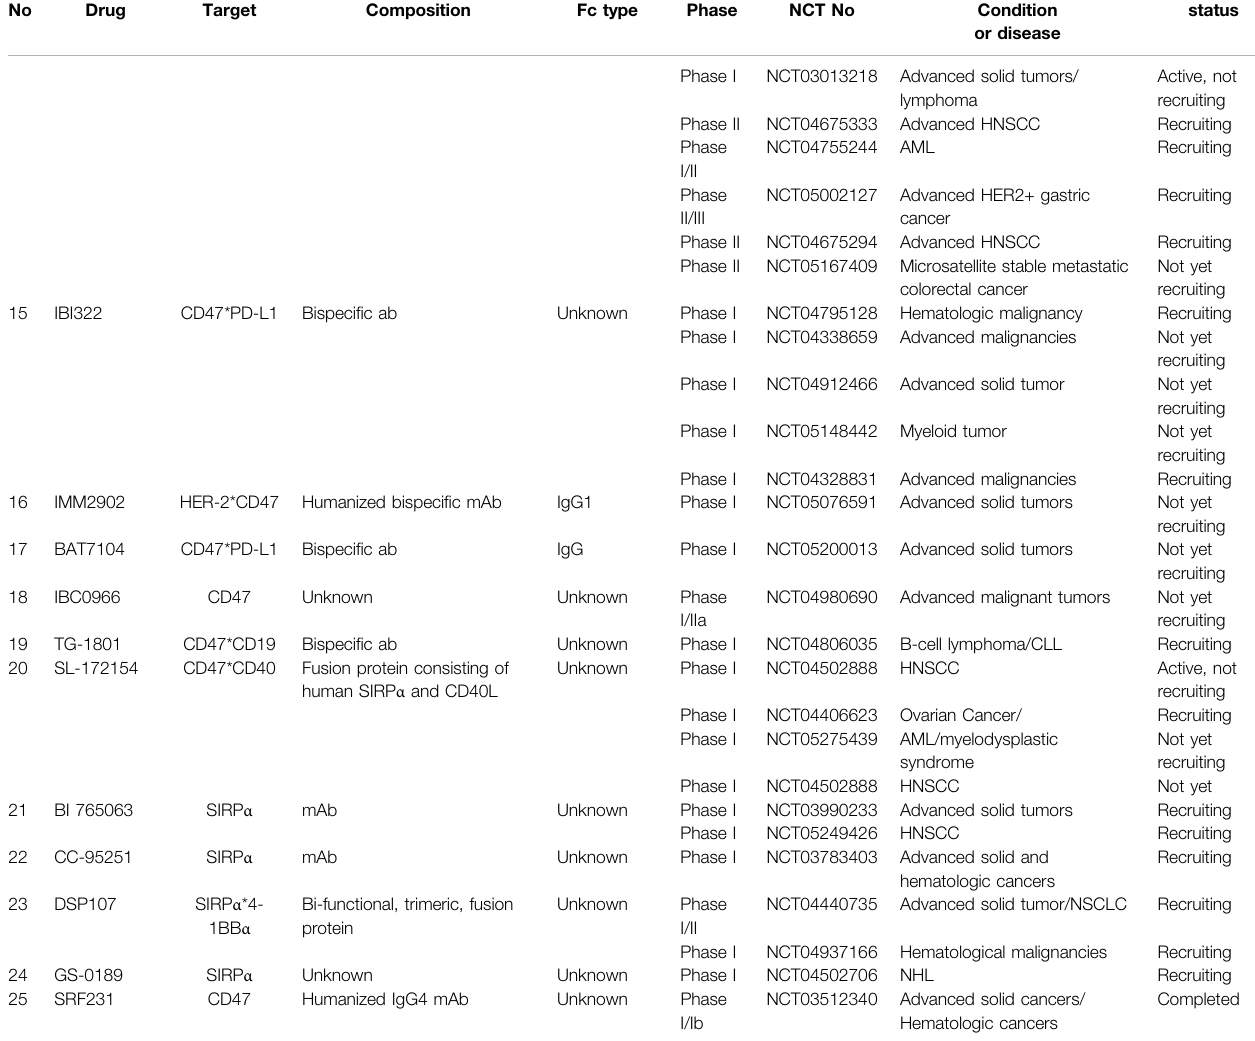
TABLE 1 | ( Continued ) List of anti-tumor clinical trials targeting CD47-SIRP α